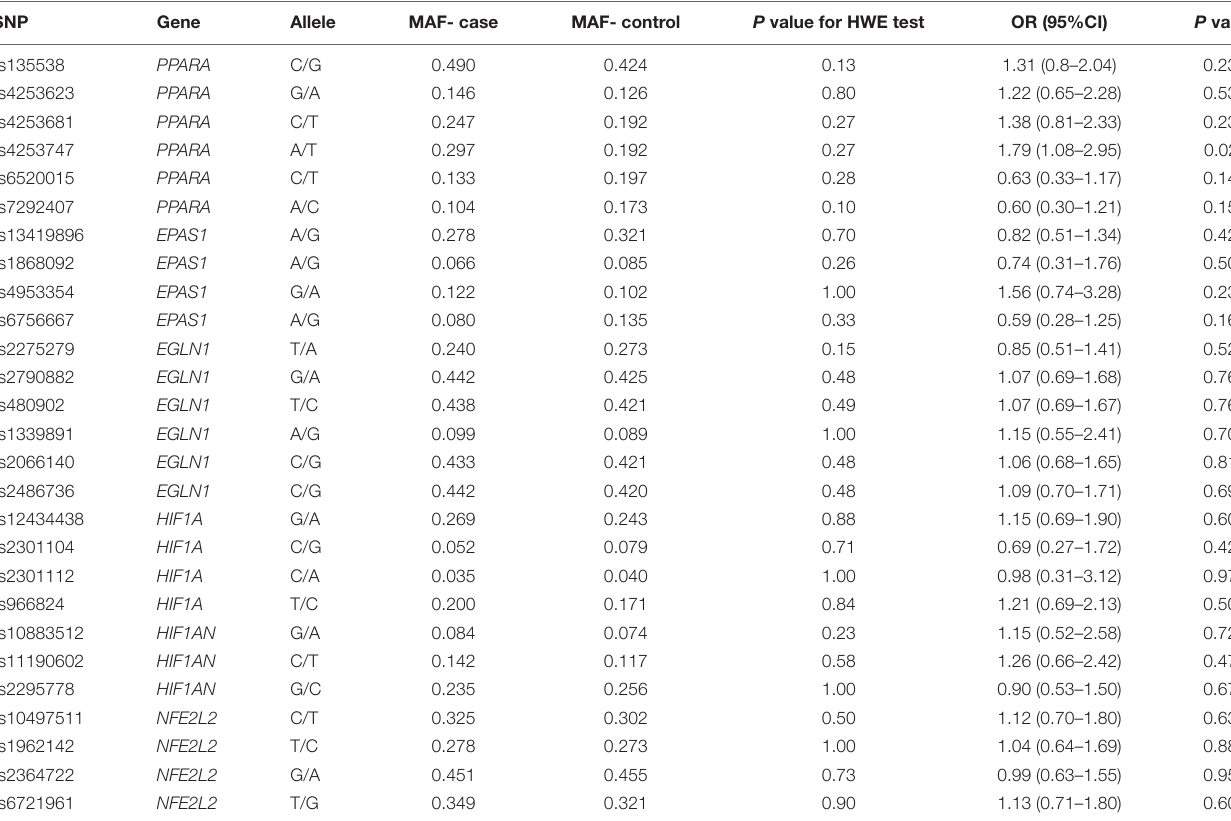
TABLE 2 | Allele frequencies in cases and controls and odds ratio estimates for HA appetite loss risk.